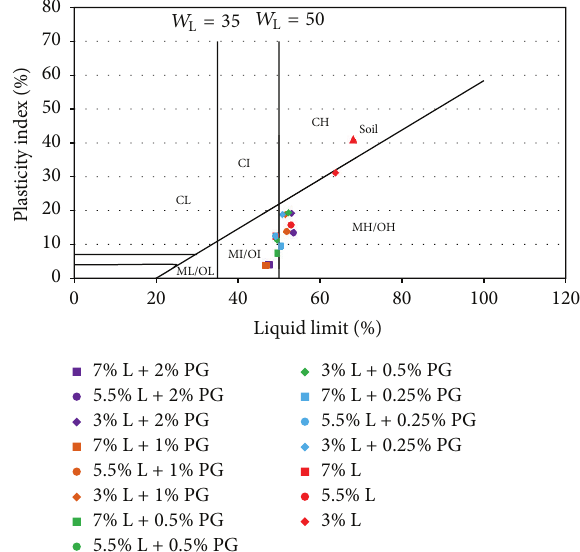
Figure 7: Locations of lime-PG stabilized soil combinations on plasticity